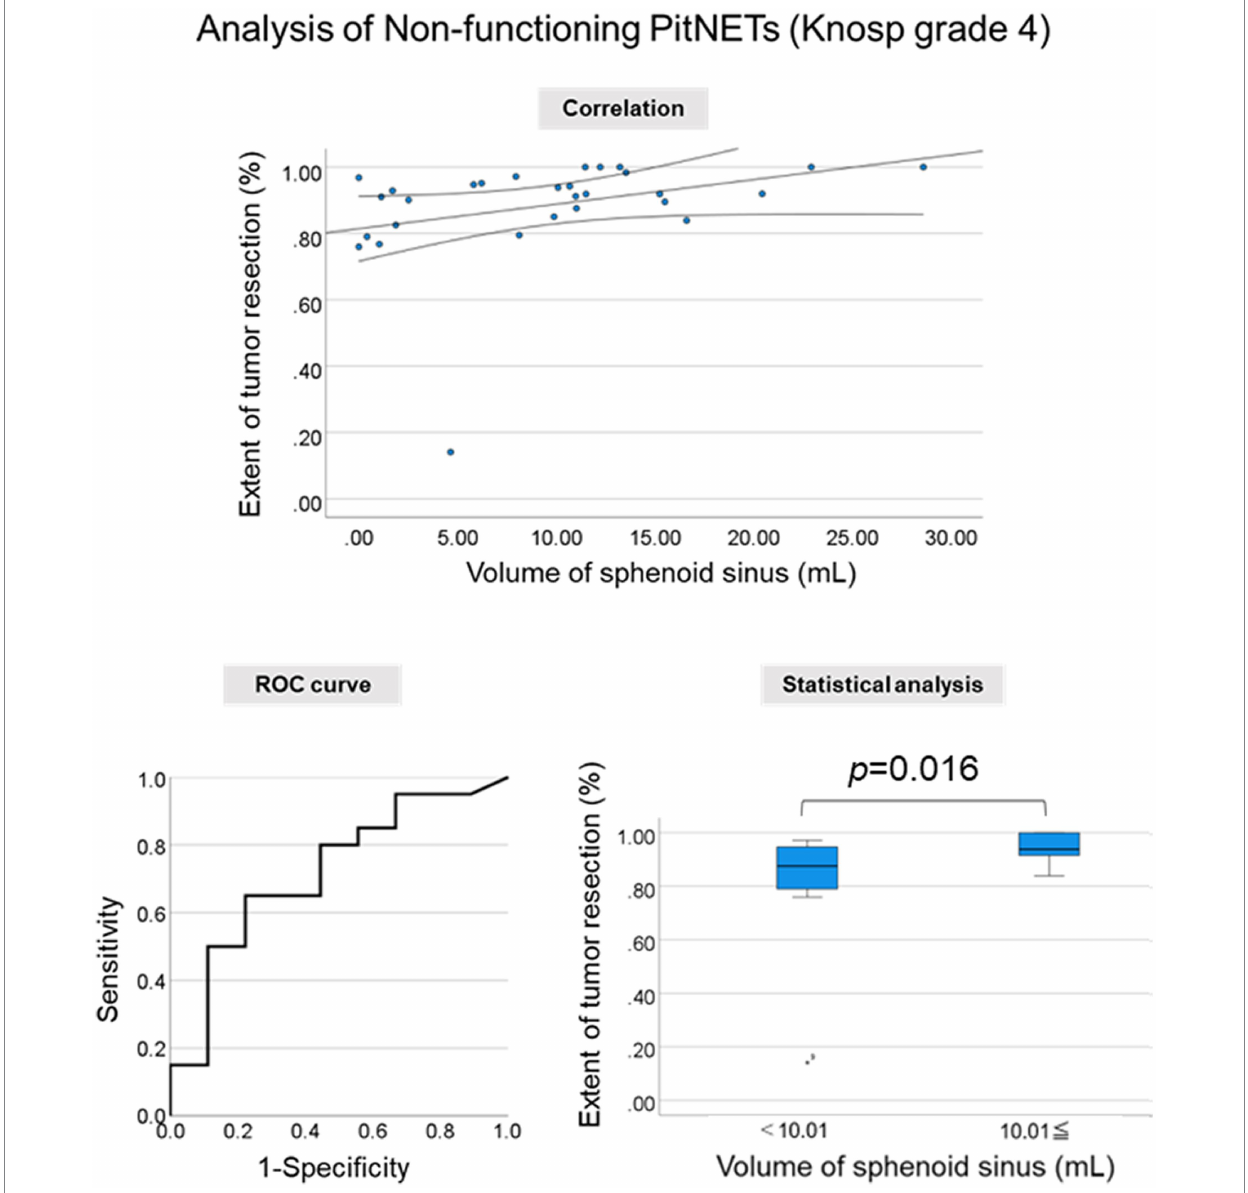
FIGURE 3 Clinical significance of the segmentation method. Correlation between the sphenoid sinus volume and the extent of tumor resection. Correlation plot (Upper Middle Panel) , receiver operating characteristic (ROC) curve (Lower Left Panel) , and extent of tumor resection in two groups divided by the cut-off value in nonfunctioning Knosp grade 4 PitNETs (Lower Right Panel)